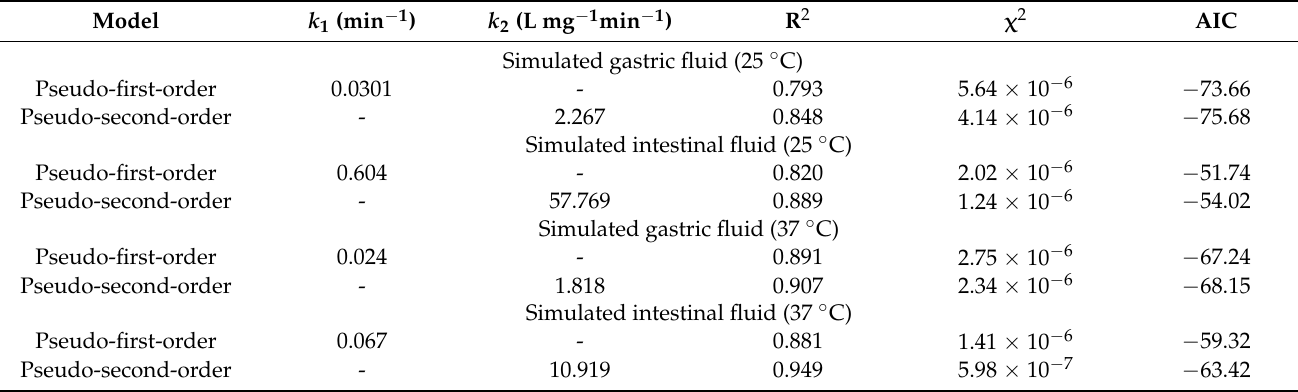
Figure 9. Results of the pseudo-first- and pseudo-second-order kinetic models during the controlled MB release from the chitosan/pectin blend hydrogel in simulated gastric fluid at 25 ◦ C ( a ) and 37 ◦ C ( c ), and simulated intestinal fluid at 25 ◦ C ( b ) and 37 ◦ C ( d ). Experimental conditions: dried hydrogel mass of 10.0 mg and constant stirring of 110 rpm. Table 4. Fitting parameters of the pseudo-first- and pseudo-second-order kinetic models for the release of MB from the chitosan/pectin blend hydrogel in different